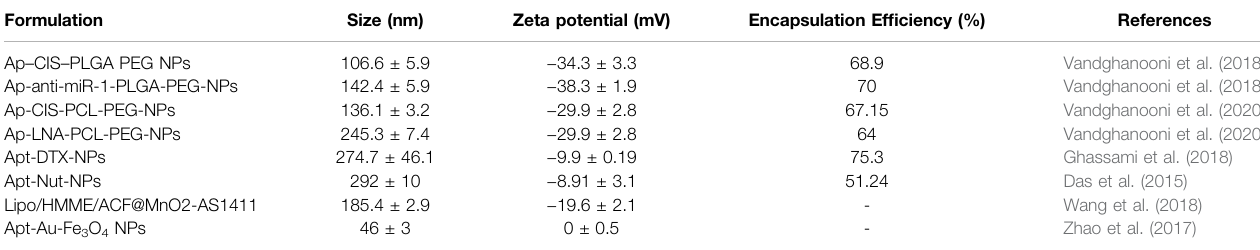
TABLE 3 | Characteristics of aptamer nanomedicines for ovarian cancer therapy.